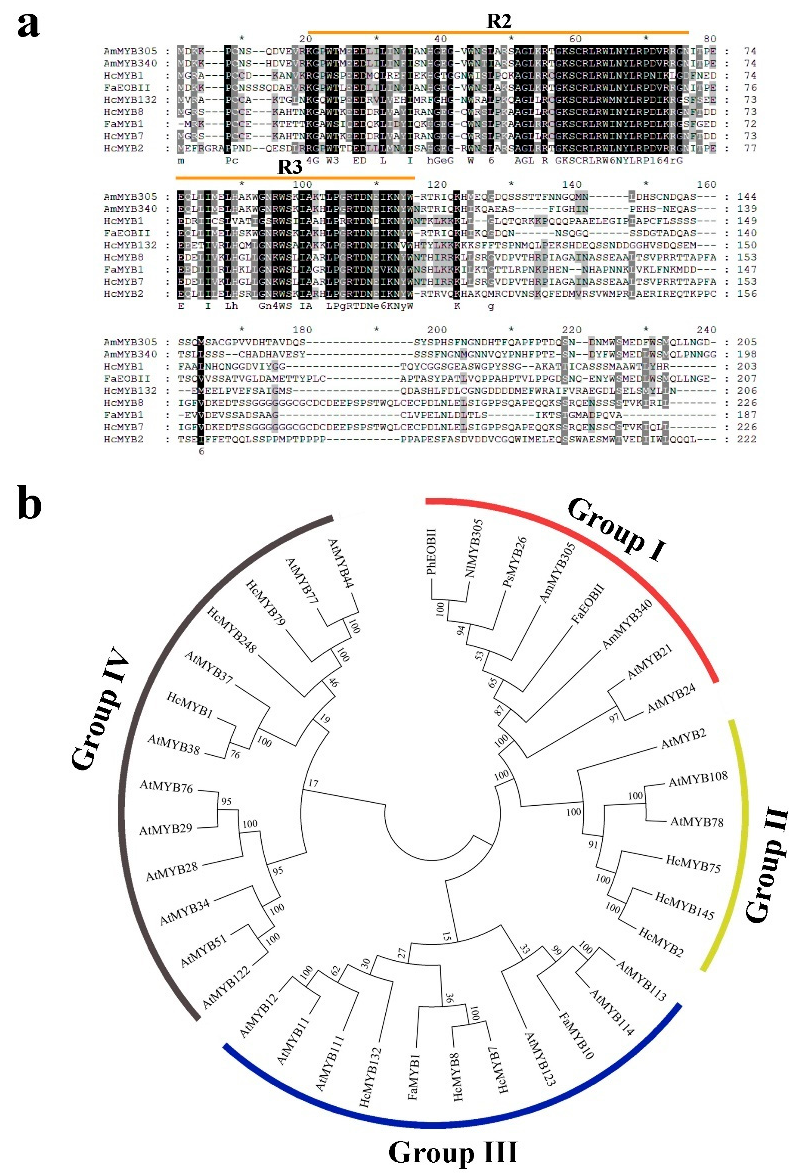
Figure 1. Sequence alignment and phylogenetic analysis of HcMYB132. ( a ) Multiple sequence alignment of HcMYB132 with R2R3-MYB proteins. Sequence alignment was performed by ClustalX 2.1 and shaded in GeneDoc. Amino acid residues are shaded in light gray, gray, and black showing 50, 70 and 100% identity, respectively, while dashes indicate gaps used for optimal alignment. R2R3 motifs are indicated by orange lines. ( b ) Phylogenetic analysis of HcMYB132 together with previously characterized R2R3-MYB proteins. The protein sequences were aligned by Clustal X 2.1 and the phylogenetic tree was built in MEGA X using the Nj method. All R2R3-MYBs are grouped into 4 subclades named G I–G IV. Genes used in phylogenetic tree and their accession numbers are listed in Table